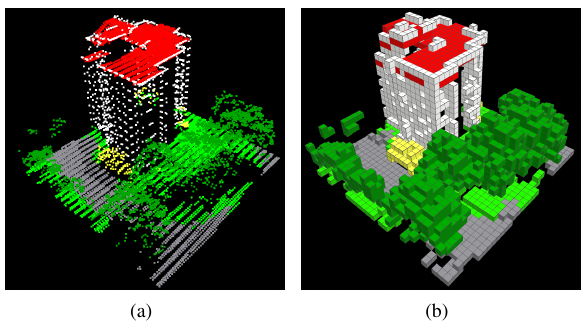
Figure 4. Voxelized V3D training sample of size 32 × 32 × 64 m with 1 m voxel size, colored by label. Light green: Low vegeta- tion; gray: Impervious surface; red: Roof; white: Facade; yellow: Shrub; medium green: